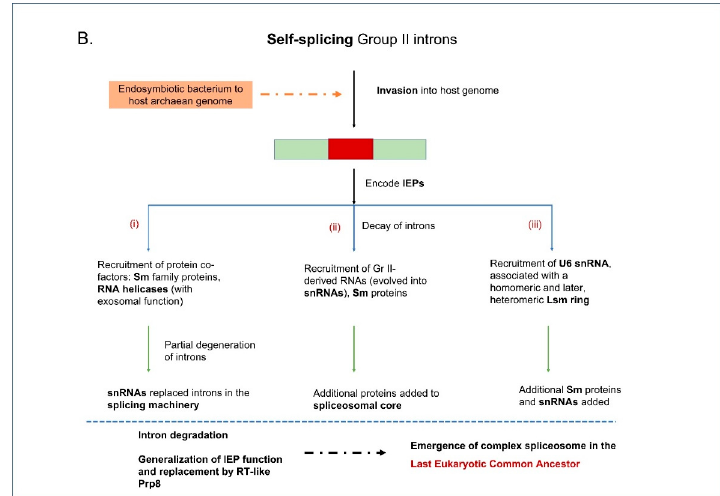
Figure 2. Probable evolutionary fates of self-splicing introns. ( A ) Homing endonuclease-open reading frame (HE-ORF) of Group I introns follow the Goddard–Burt life cycle, with slightly altered fates in bacterial derived organelles (mitochondria and chloroplasts) and archaeal derived nuclear genomes. (i) For bacterial derived organelles, the Group I ribozyme is conserved in the absence of tRNA endonuclease and ligase and is eventually lost during evolution when the intron function is lost or becomes redundant; (ii) For archaea derived nuclear genomes, the Group I ribozyme ability was lost in favor of an alternate intron removal pathway recruiting the tRNA endonuclease and ligase. Because of this recruitment, the Group I introns in archaea have probably evolved into BHB introns, both can encode homing endonucleases and these intron types can be distinguished by com- putational approaches [71]. ( B ) Origin of spliceosome from Group II introns involves domestication of the self-splicing introns (during eukaryogenesis) and recruitment of protein components into the spliceosome. The order of intron decay and protein recruitment is debatable; (i) Recruitment-first theory: recruitment of Smith antigen (Sm) protein cofactors, followed by RNA helicase (with probable exosomal function); subsequent partial degeneration of the introns [74]; (ii) Decay-first theory: decay of self-splicing introns, requiring the recruitment of Group II-derived RNAs, which evolved into the small nuclear RNAs (snRNAs), and associated Sm proteins [5]; (iii) ‘Frozen event’ theory: starts with RNA components, at least U6 snRNA, associated with a homomeric, and later heteromeric Sm-like (Lsm) ring whose interaction can be seen as a ‘frozen event’; addition of other snRNAs, accompanied by the Sm ring. Irrespective of the order of events, eventually intron degradation and substitution of Group II intron activity by reverse transcriptase (RT)-like pre-mRNA splicing factor 8 (Prp8) activity led to the emergence of the complex spliceosome in the last common eukaryotic ancestor (LECA)